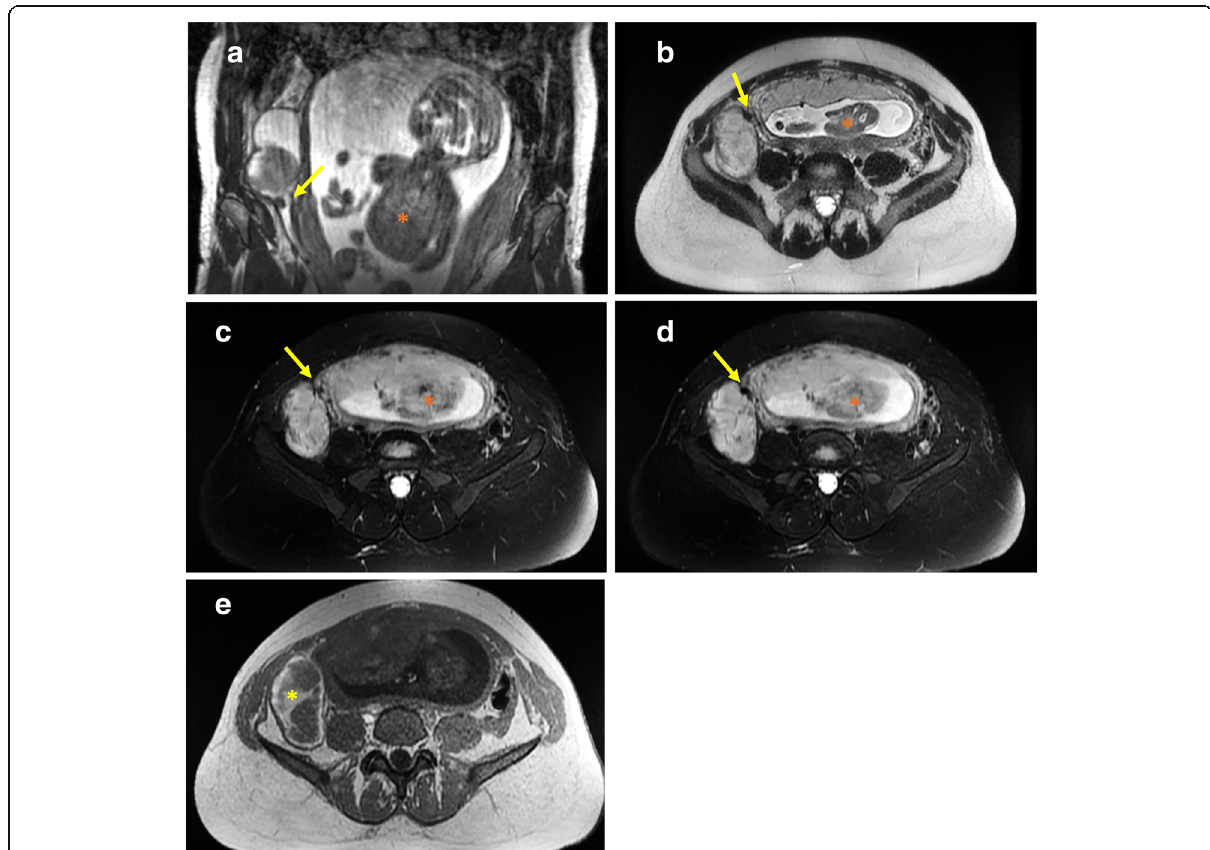
Fig. 1 MRI shows a well-defined and heterogeneous tumor, with predominantly high signal intensity on coronal ( a ) and axial T2-weighted images without ( b ) and with ( c, d ) fat saturation images; it contains hyperintense areas on axial T1-weighted images ( e ) consistent with the presence of blood content (yellow asterisk). It also demonstrated a hypointense vascular pedicle representing feeding vessels that arise from the uterine arteries, coursing from the uterus into an adjacent exophytic pelvic mass (yellow arrow) —“ bridging vessel sign ” ; this sign reveals the uterine origin of the pelvic mass. A single fetus is also seen (orange